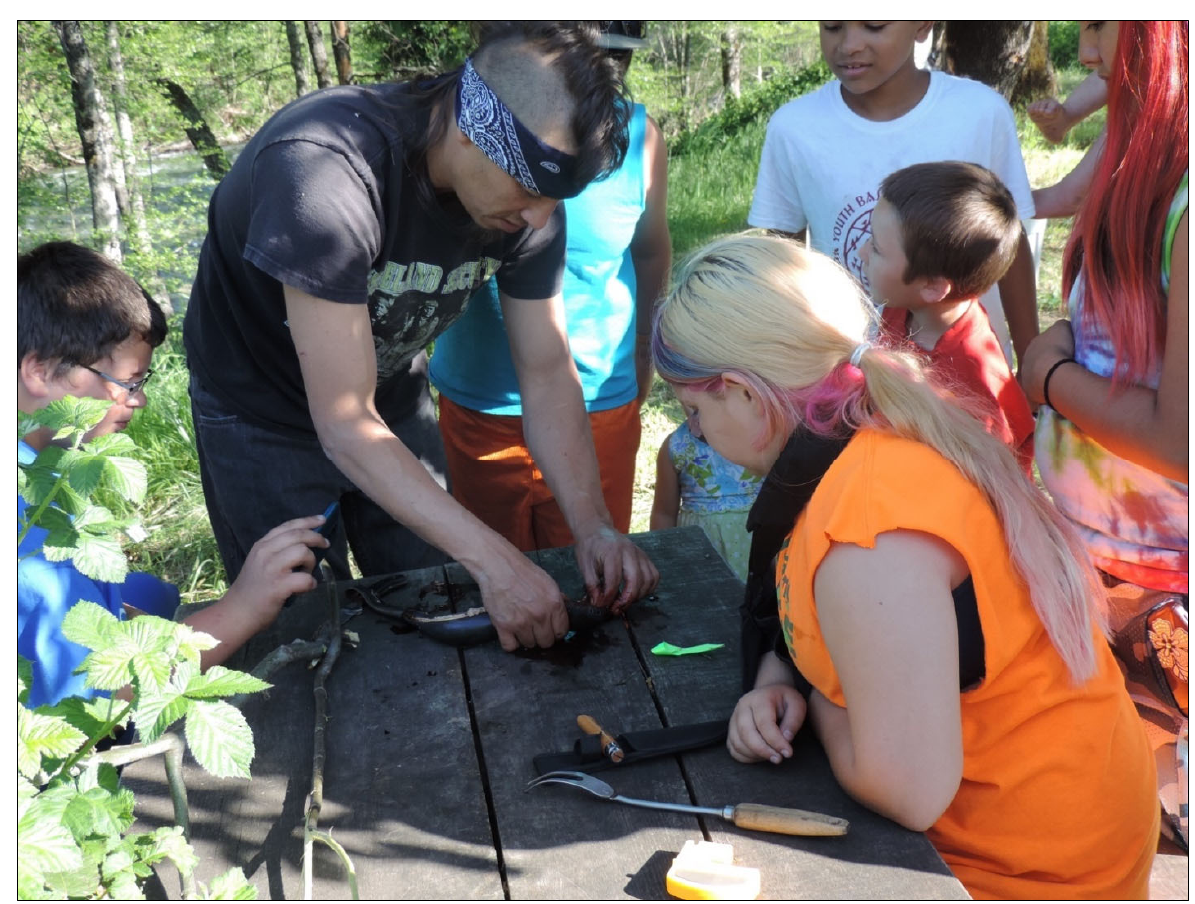
Figure 2. Youth in Happy Camp, California, Learn How to Prepare and Cook Pacific Lamprey ( Lampetra tridentate